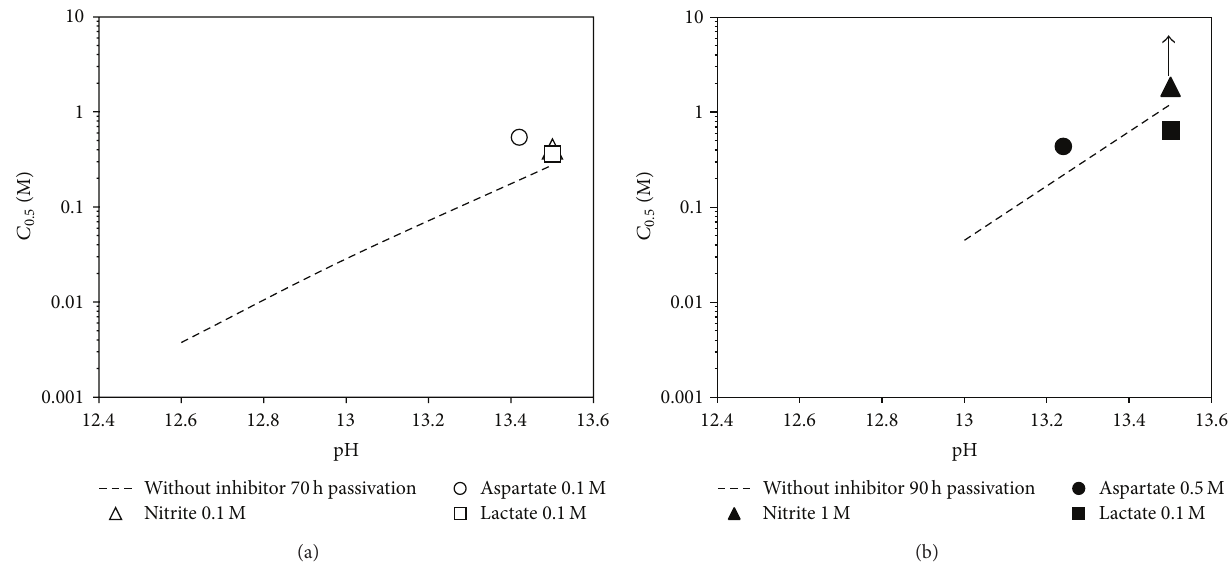
Figure 8: Effect of pH on critical chloride content during multispecimen potentiostatic tests (a) at 70 h of passivation and (b) at 90 h of passivation; C 0.5 was not reached in the case of nitrites.